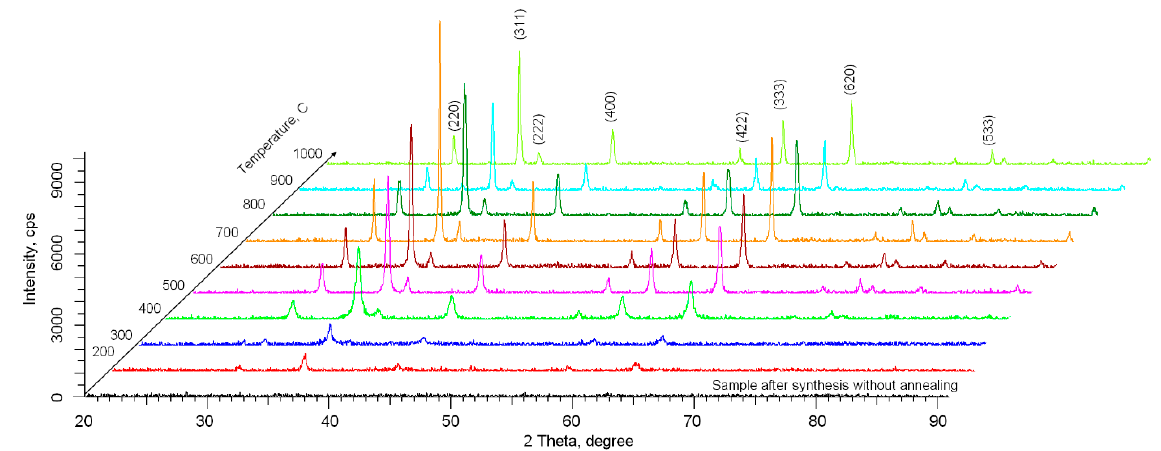
Figure 2. X-ray diffractograms of synthesized NiFe 2 O 4 nanoparticles as a function of annealing temperature.